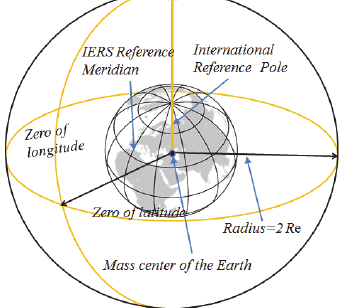
Figure 1 Reference spheroid for ESSG-based GSRF. The origin and the prime meridian set to be the center of mass of the Earth and the IERS Reference Meridian, respectively. The rotation axis is pointed to the International Reference Pole (IRP), and the radius of the reference spheroid is set to be 2 Re ( Re=6,400km ).  Rotation axis The rotation axis is pointed to the International Reference Pole (IRP) as defined by IERS, which is the mean position of the Earth's spin axis between 1900.0 and